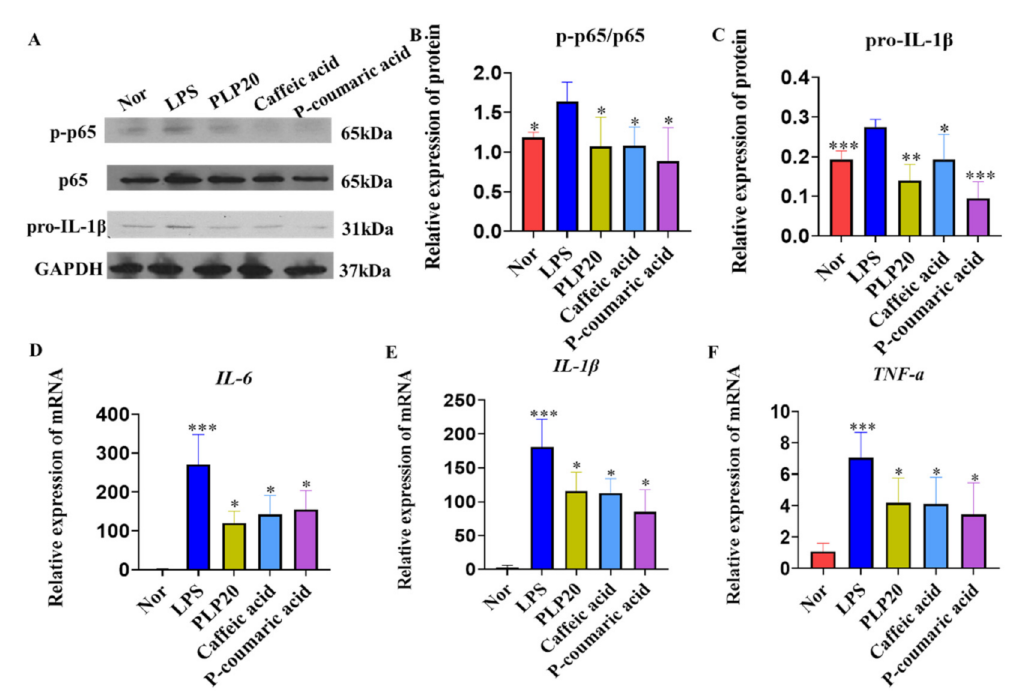
Figure 3. PLPs, Caffeic acid, and P-coumaric acid inhibited the secretion of pro-inflammatory factors and the activation of NF- κ B cell signaling in LPS-stimulated RAW264.7 cells. RAW264.7 cells were stimulated with LPS (1 µ g/mL) and treated with PLPs (20 µ g/mL), Caffeic acid (10 µ g/mL), and P-coumaric acid (10 µ g/mL) for 12 h ( A – F ). p-p65, p65, and IL-1 β were detected by Western blot ( A – C ). IL-6, IL-1 β , and TNF- α mRNA in colon tissue were determined by real-time PCR ( D – F ). Nor: normal control cells; LPS: lipopolysaccharide-induced control cells; PLP20: pineapple leaf